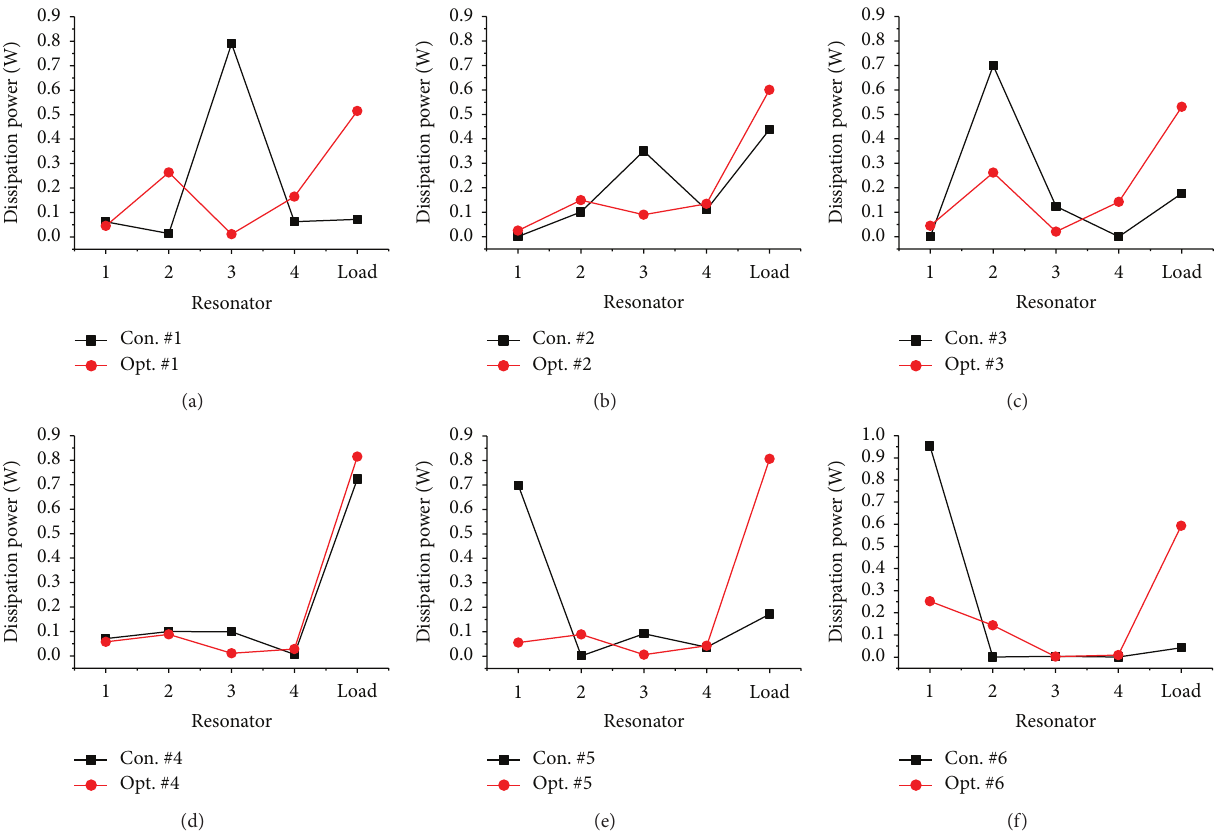
Figure 7: Dissipated power at four resonators and the load ( 𝑃 in = 1 W).